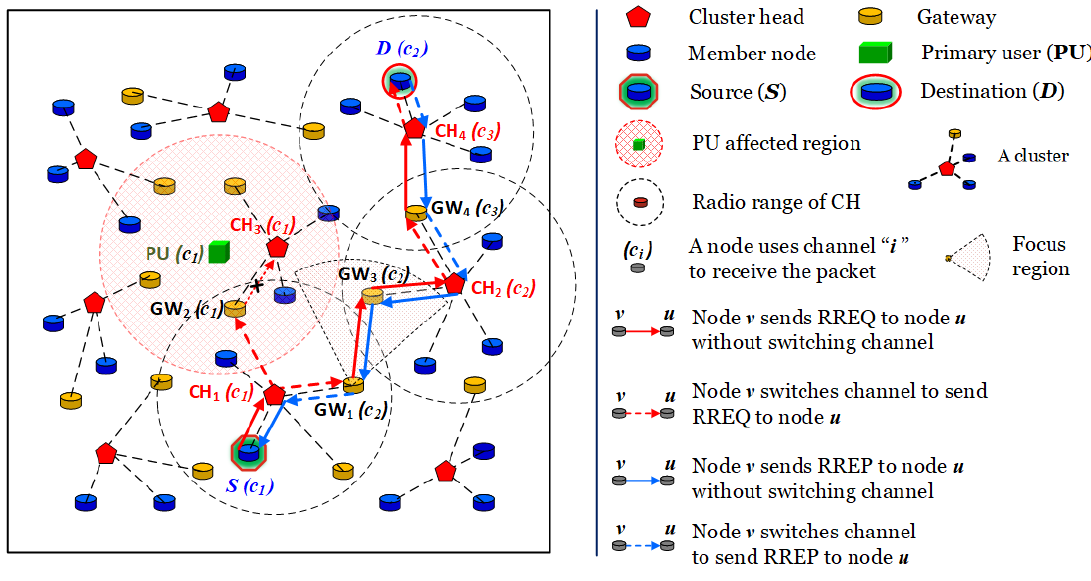
Figure 1. A multi-channel cognitive mobile ad-hoc network (MANET): Basic concepts of the system